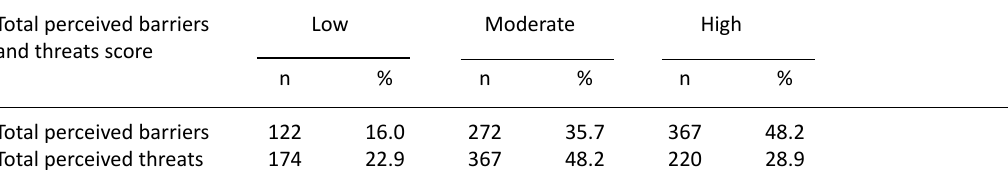
table 3. Percent distribution of the study participants according to their total perceived barriers and threats score